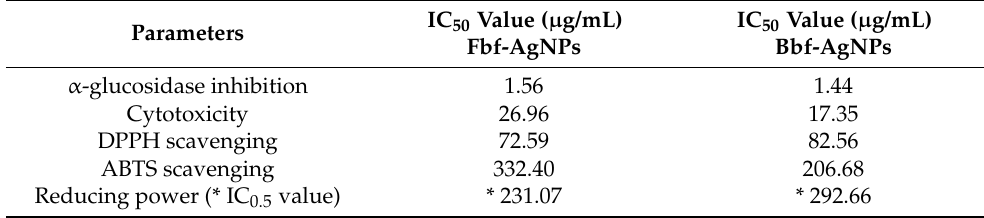
Table 2. IC 50 values of, Fbf-AgNPs and Bbf-AgNPs in the antioxidant, α -glucosidase inhibition, and cytotoxicity studies.